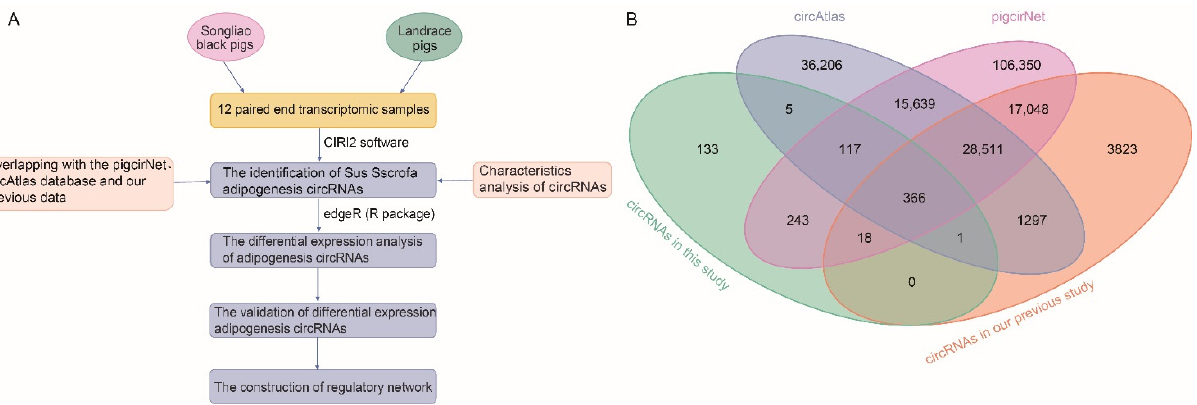
Figure 1. Identification of Ssc circRNAs. ( A ) The pipeline for circRNAs identification. ( B ) Venn diagram shows the intersection of circRNAs identified in this study (circRNAs in this study) with circRNAs from pigcircNet, circAtlas databases and circRNAs in our previous study.